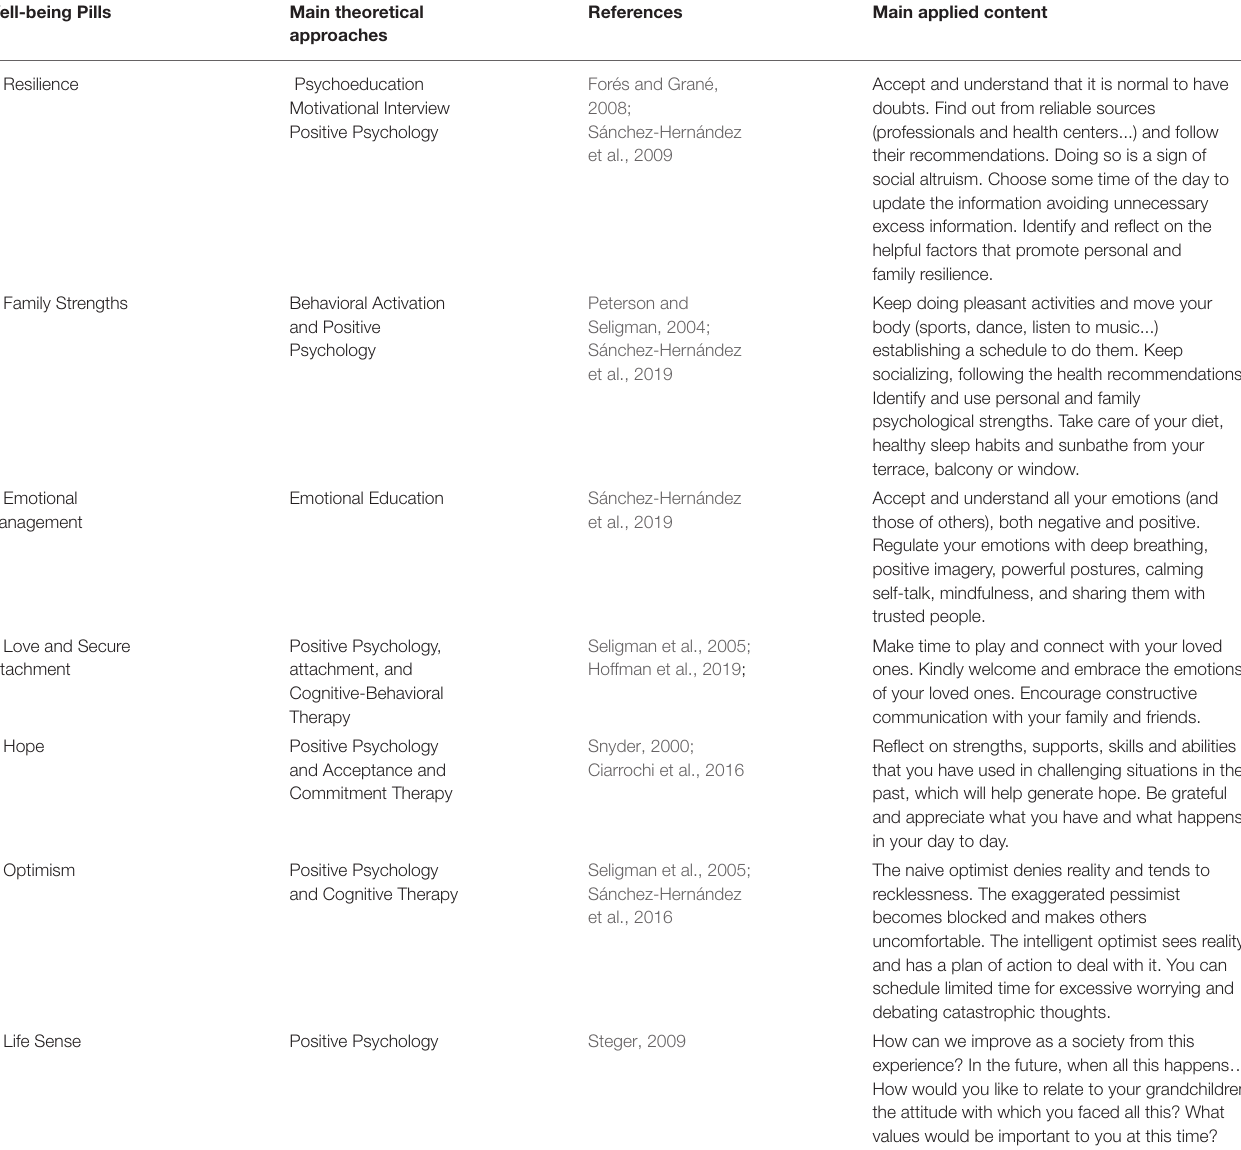
TABLE 1 | Well-being Pills from the resilience and wellness program: “stay at home” (Sánchez-Hernández and Canales, 2020b). Well-being